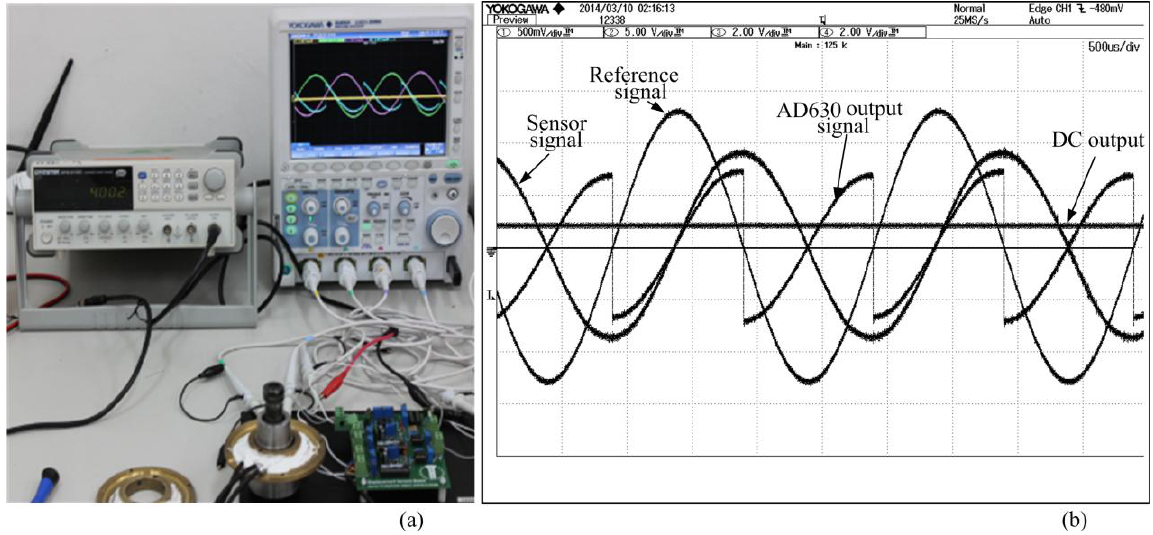
Figure 19. Experimental result in oscilloscope, ( a ) Experimental board setup; ( b ) Signal